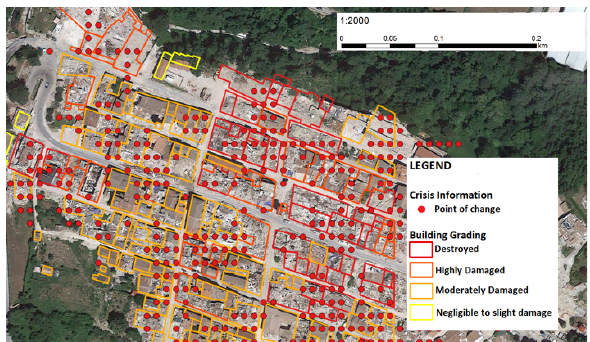
Figure 7. CCD results visualization for the descending-pass stack over aerial imagery and grading map of the urban area of Amatrice produced by Copernicus Emergency Management Service and e-GEOS (Situation as of